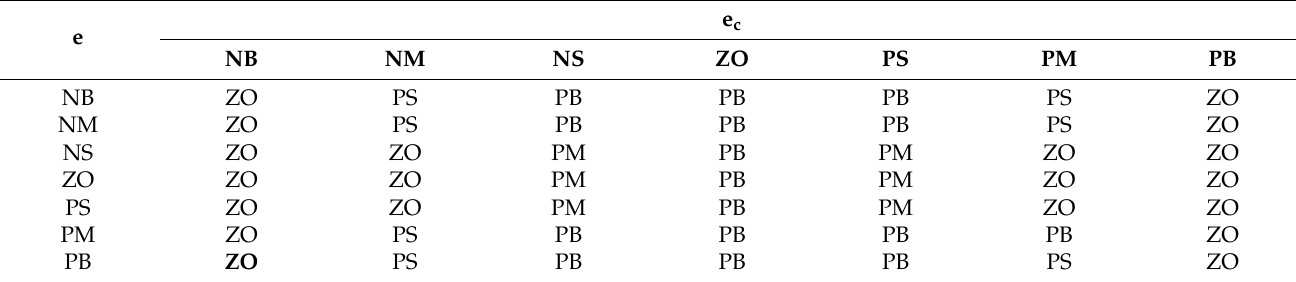
Table 2. The fuzzy rules matrix of ∆ k i .